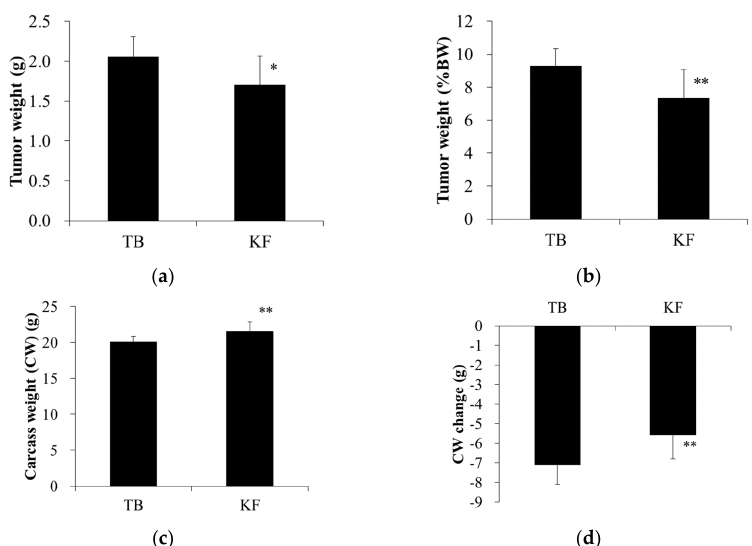
Figure 2. Effect of ketogenic diet on tumor weight and carcass weight in a mouse model of colorectal cancer. Legend: ( a , b ) tumor weights and ( c , d ) carcass weights at the day of necropsy (day 21 after tumor inoculation). Values are means ± standard deviations. * p < 0.05, ** p < 0.01, vs. TB group. BW, body weight; TB, tumor-bearing group; KF, ketogenic formula group.